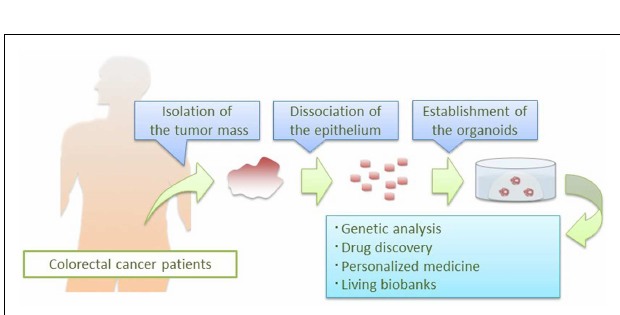
FIGURE 1 | Organoid culture of normal and tumor epithelium . Normal intestinal epithelial cells and colorectal cancer (CRC) cells are isolated from intestine and cultured in Matrigel and optimal niche